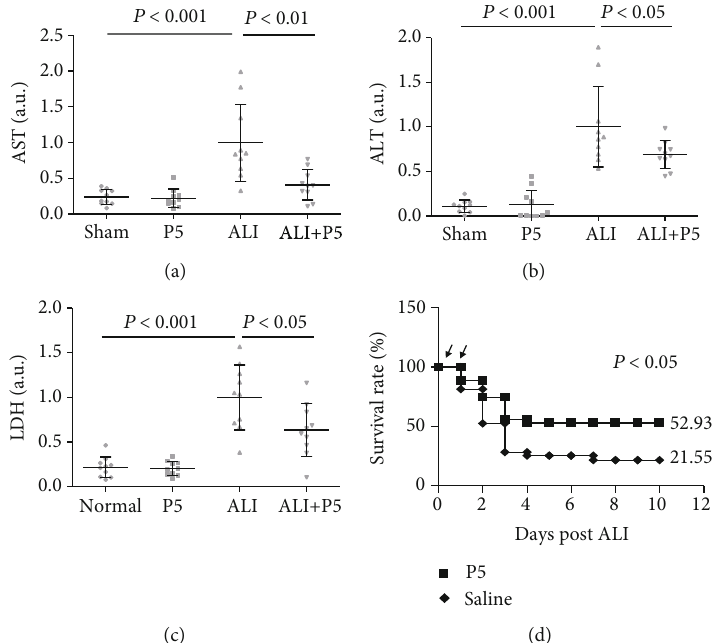
Figure 4: E ff ects of P5 on the levels of ALT (a), AST (b), and LDH (c) in BALF and survival rate (d) of ALI mice. (a – c) Mouse ALI induction and treatments were performed in the same fashion as in Figure 3(b). The relative levels of AST (a), ALT (b), and LDH (c) in BALF were assessed by Western blotting. n = 10 . ∗ P < 0 : 05 . Values are in arbitrary units (a.u.). (d) Same volume (200 μ l) saline or P5 (8 mg/kg) was administered twice through ip at 2 and 16 hr post-ALI induction (5 mg/kg LPS, intratracheal instillation) in Balb/c mice. Survivors were counted daily for 10 days. Arrows indicate the time of saline or P5 injections, n = 30